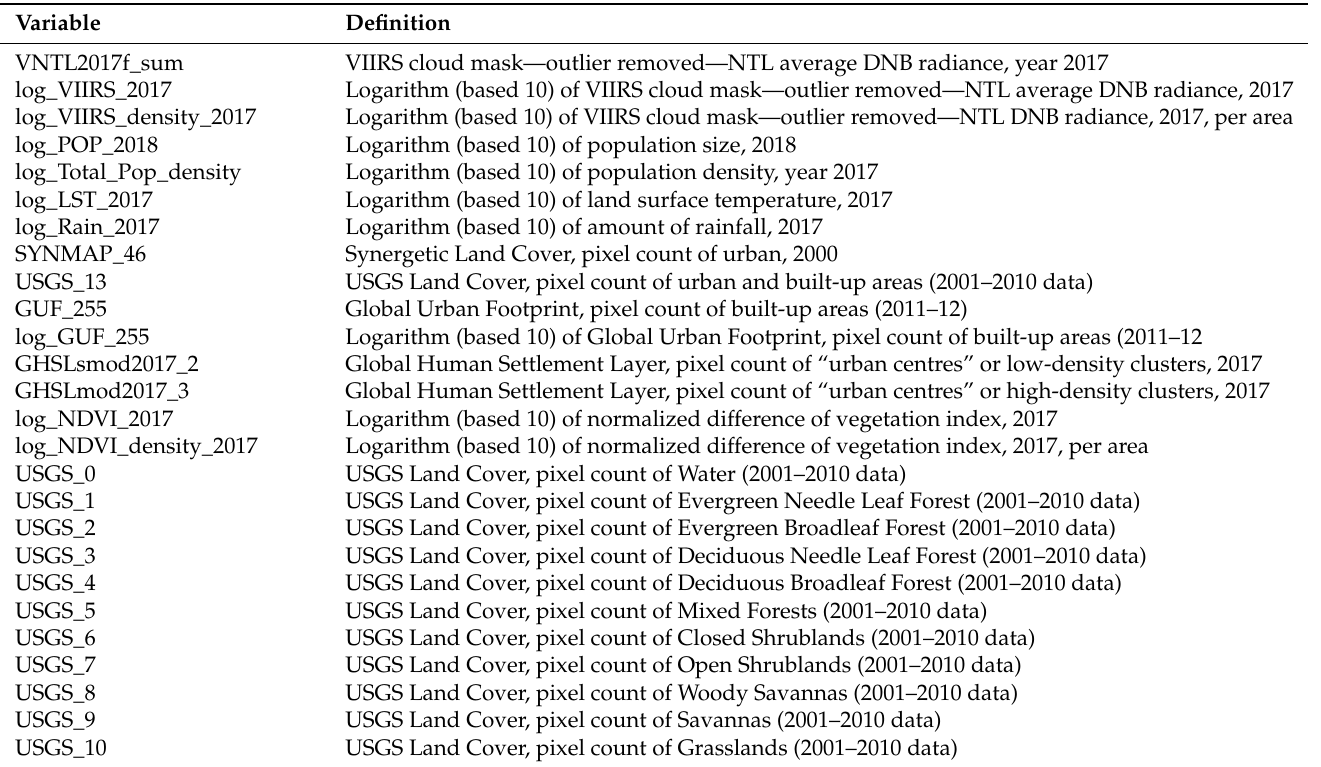
Table A2. List of variables obtained from geospatial data of